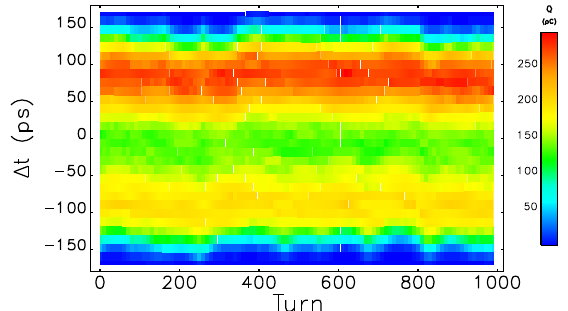
FIG. 17. Main-cavity phase of each unique bunch for the case of 12 simple gaps (uniform bunch charge) and 12 compensated